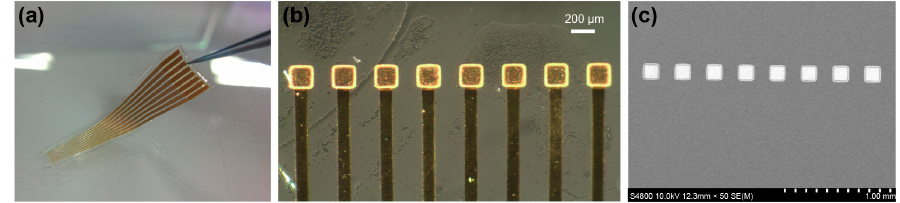
Figure 3. Images of fabricated PDMS-based plateau MEA. ( a ) The overall appearance of the MEA. The sacrificial photoresist post of this sample was spin-coated twice at 1300 rpm for 20 s. The thickness was 20 μ m and the depth of the PDMS hole was 11 μ m. ( b ) Optical microscope image of the plateau microelectrodes. The bright region around the electrode is the gold film on the wall of the PDMS hole. ( c ) SEM image of the plateau microelectrodes. As the gold wires are inside the PDMS, we could not observe them using SEM. The electrodes were deposited with dimensions of 100 μ m × 100 μ m, but the SEM measurements show dimensions of 130 μ m × 130 μ m. The increase in electrode size is caused by the addition of the 160 μ m PET film and the shrinking and etching of PDMS as a result of the NMP and TBAF solutions.